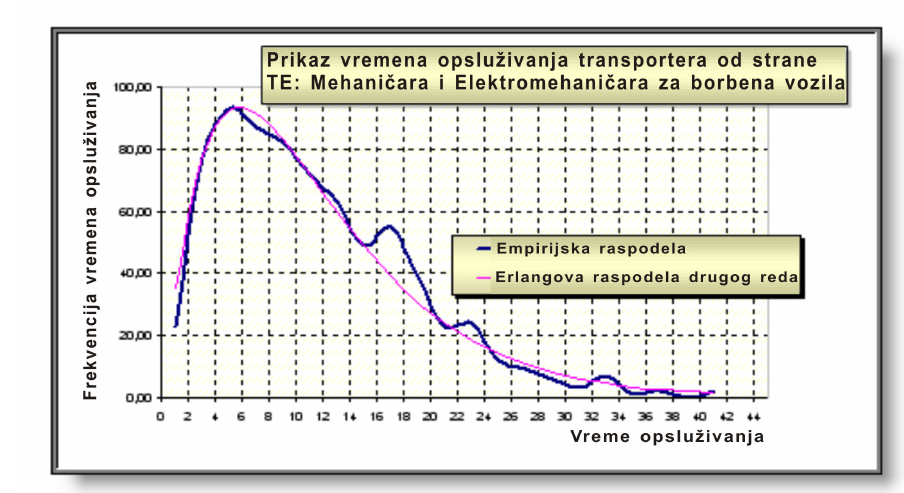
Figure 7 – M-80 served by mechanics and electro-mechanics for c/v Analogno prethodnom, razmatran je ulazni potok tenkova (M-84), ta-